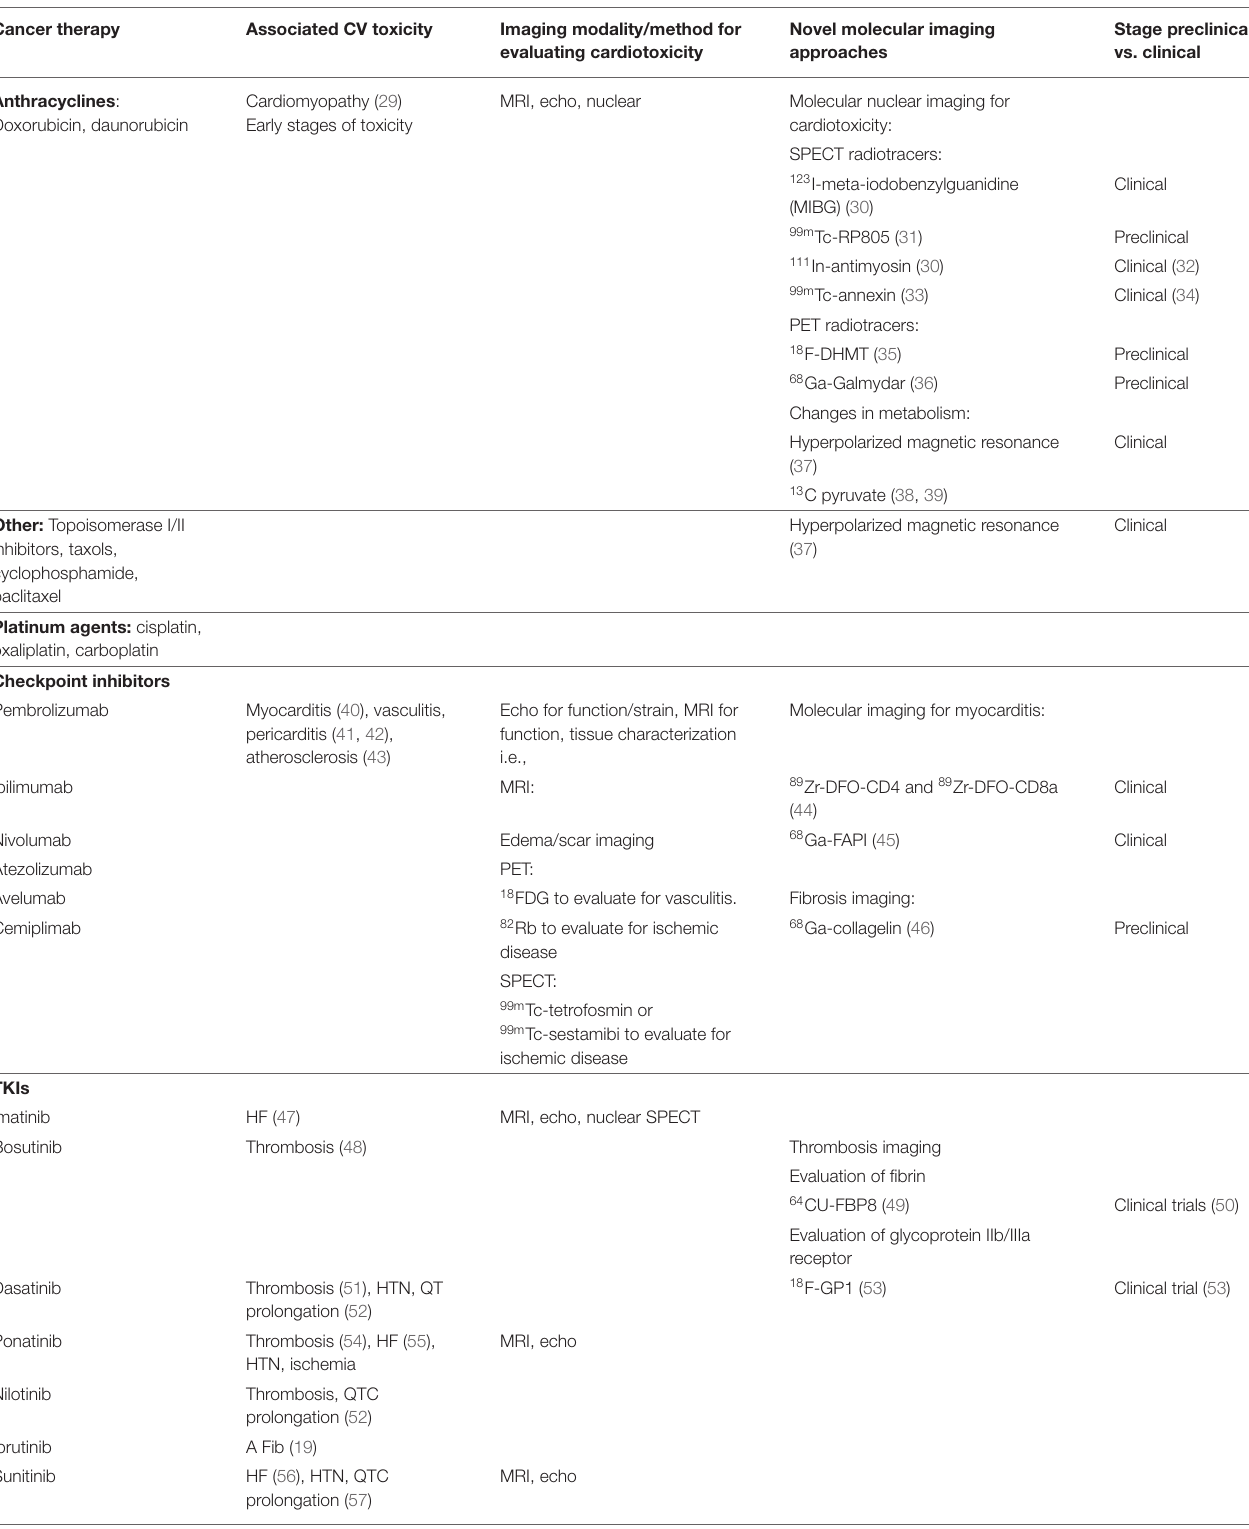
TABLE 1 | Cancer therapy, associated CV toxicity and imaging